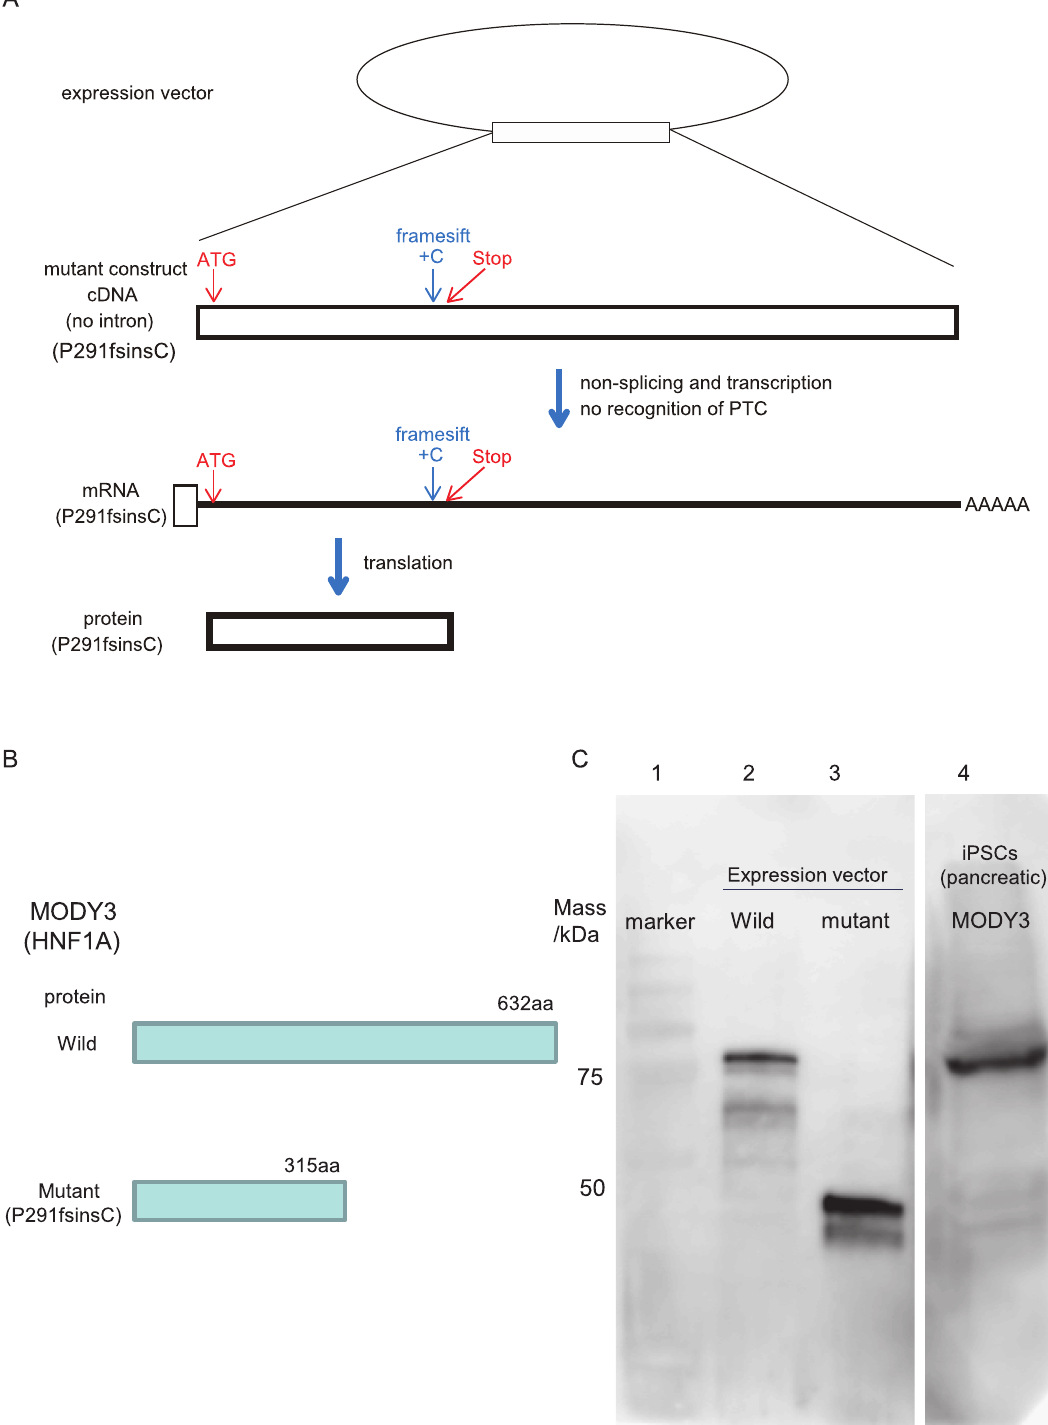
PLOS ONE | https://doi.org/10.1371/journal.pone.0217110 May 30,